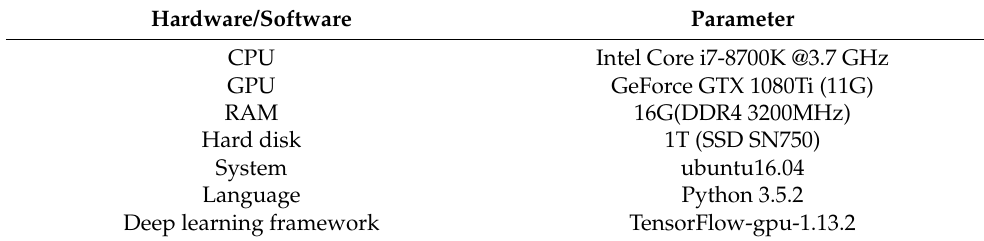
Table 1. Experiment environment.